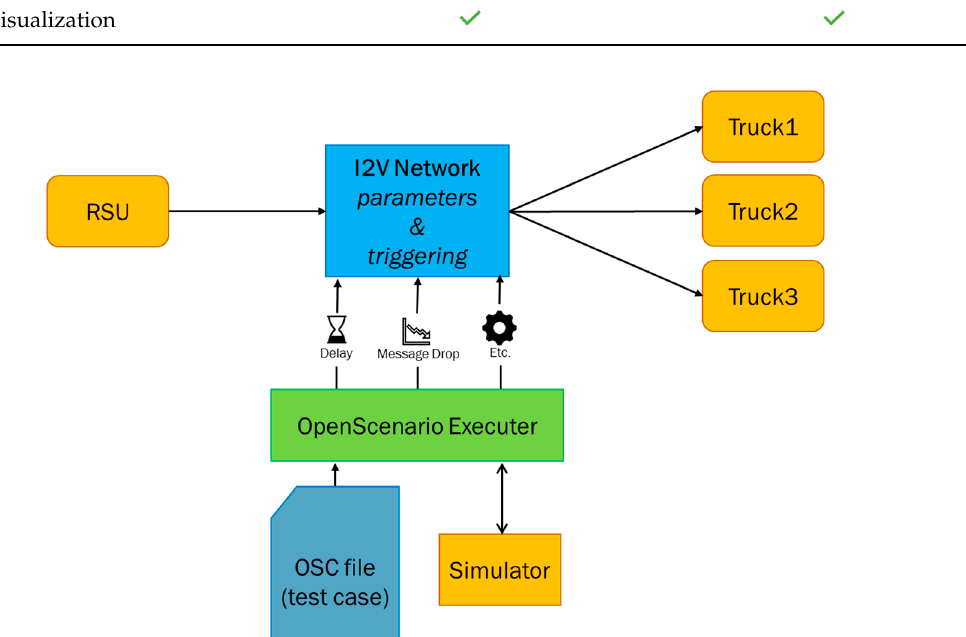
modifying the OpenSCENARIO v.0.9.1 specification [28], and also by a HiL OpenSCE- component with the other HiL components is illustrated in Figure 7. Table 1. Functional adaptation of the HiL setup from the ENSEMBLE implementation to the HEADSTART implementation Table 1. Functional adaptation of the HiL setup from the ENSEMBLE implementation to the HEADSTART implementation [19]. indicates that the implementation makes use of the functionality, means no use is made of the functionality and shows that a [19]. [19]. Table 1. Functional adaptation of the HiL setup from the ENSEMBLE implementation to the HEADSTART implementation indicates that the implementation makes use of the functionality, means no use is made of the functionality and Table 1. Functional adaptation of the HiL setup from the ENSEMBLE implementation to the HEADSTART implementation [19]. specific implementation has been added to the ENSEMBLE HiL. indicates that the implementation makes use of the functionality, means no use is made of the functionality and shows that a indicates that the implementation makes use of the functionality, means no use is made of the functionality and shows that a shows that a specific implementation has been added to the ENSEMBLE HiL. specific implementation has been added to the ENSEMBLE HiL. specific implementation has been added to the ENSEMBLE HiL. Table 1. Functional adaptation of the HiL setup from the ENSEMBLE implementation to the HEADSTART implementation [19]. Table 1. Functional adaptation of the HiL setup from the ENSEMBLE implementation to the HEADSTART implementation [19]. Table 1. Functional adaptation of the HiL setup from the ENSEMBLE implementation to the HEADSTART implementation [19]. indicates that the implementation makes use of the functionality, means no use is made of the functionality and shows that a indicates that the implementation makes use of the functionality, means no use is made of the functionality and shows that a Simulated sensors (radar, camera, lidar) Table 1. Functional adaptation of the HiL setup from the ENSEMBLE implementation to the HEADSTART implementation [19]. indicates that the implementation makes use of the functionality, means no use is made of the functionality and shows that a specific implementation has been added to the ENSEMBLE HiL. specific implementation has been added to the ENSEMBLE HiL. Table 1. Functional adaptation of the HiL setup from the ENSEMBLE implementation to the HEADSTART implementation [19]. specific implementation has been added to the ENSEMBLE HiL. indicates that the implementation makes use of the functionality, means no use is made of the functionality and shows that a indicates that the implementation makes use of the functionality, means no use is made of the functionality and shows that a Table 1. Functional adaptation of the HiL setup from the ENSEMBLE implementation to the HEADSTART implementation [19]. specific implementation has been added to the ENSEMBLE HiL. specific implementation has been added to the ENSEMBLE HiL. indicates that the implementation makes use of the functionality, means no use is made of the functionality and shows that a Table 1. Functional adaptation of the HiL setup from the ENSEMBLE implementation to the HEADSTART implementation [19]. specific implementation has been added to the ENSEMBLE HiL. indicates that the implementation makes use of the functionality, means no use is made of the functionality and shows that a Table 1. Functional adaptation of the HiL setup from the ENSEMBLE implementation to the HEADSTART implementation [19]. specific implementation has been added to the ENSEMBLE HiL. indicates that the implementation makes use of the functionality, means no use is made of the functionality and shows that a specific implementation has been added to the ENSEMBLE HiL. Table 1. Functional adaptation of the HiL setup from the ENSEMBLE implementation to the HEADSTART implementation [19]. Table 1. Functional adaptation of the HiL setup from the ENSEMBLE implementation to the HEADSTART implementation [19]. indicates that the implementation makes use of the functionality, means no use is made of the functionality and shows that a indicates that the implementation makes use of the functionality, means no use is made of the functionality and shows that a specific implementation has been added to the ENSEMBLE HiL. specific implementation has been added to the ENSEMBLE HiL. Table 1. Functional adaptation of the HiL setup from the ENSEMBLE implementation to the HEADSTART implementation [19]. Table 1. Functional adaptation of the HiL setup from the ENSEMBLE implementation to the HEADSTART implementation [19]. indicates that the implementation makes use of the functionality, means no use is made of the functionality and shows that a indicates that the implementation makes use of the functionality, means no use is made of the functionality and shows that a Table 1. Functional adaptation of the HiL setup from the ENSEMBLE implementation to the HEADSTART implementation [19]. Table 1. Functional adaptation of the HiL setup from the ENSEMBLE implementation to the HEADSTART implementation [19]. specific implementation has been added to the ENSEMBLE HiL. specific implementation has been added to the ENSEMBLE HiL. indicates that the implementation makes use of the functionality, means no use is made of the functionality and shows that a indicates that the implementation makes use of the functionality, means no use is made of the functionality and shows that a specific implementation has been added to the ENSEMBLE HiL. specific implementation has been added to the ENSEMBLE HiL. Table 1. Functional adaptation of the HiL setup from the ENSEMBLE implementation to the HEADSTART implementation [19]. OpenSCENARIO v0.9.1 Table 1. Functional adaptation of the HiL setup from the ENSEMBLE implementation to the HEADSTART implementation [19]. indicates that the implementation makes use of the functionality, means no use is made of the functionality and shows that a Table 1. Functional adaptation of the HiL setup from the ENSEMBLE implementation to the HEADSTART implementation [19]. specific implementation has been added to the ENSEMBLE HiL. indicates that the implementation makes use of the functionality, means no use is made of the functionality and shows that a indicates that the implementation makes use of the functionality, means no use is made of the functionality and shows that a specific implementation has been added to the ENSEMBLE HiL. specific implementation has been added to the ENSEMBLE HiL. Table 1. Functional adaptation of the HiL setup from the ENSEMBLE implementation to the HEADSTART implementation [19]. indicates that the implementation makes use of the functionality, means no use is made of the functionality and shows that a Table 1. Functional adaptation of the HiL setup from the ENSEMBLE implementation to the HEADSTART implementation [19]. Functionality High fidelity specific implementation has been added to the ENSEMBLE HiL. indicates that the implementation makes use of the functionality, means no use is made of the functionality and shows that a specific implementation has been added to the ENSEMBLE HiL. Table 1. Functional adaptation of the HiL setup from the ENSEMBLE implementation to the HEADSTART implementation [19]. Table 1. Functional adaptation of the HiL setup from the ENSEMBLE implementation to the HEADSTART implementation [19]. indicates that the implementation makes use of the functionality, means no use is made of the functionality and shows that a indicates that the implementation makes use of the functionality, means no use is made of the functionality and shows that a Functionality specific implementation has been added to the ENSEMBLE HiL. specific implementation has been added to the ENSEMBLE HiL.